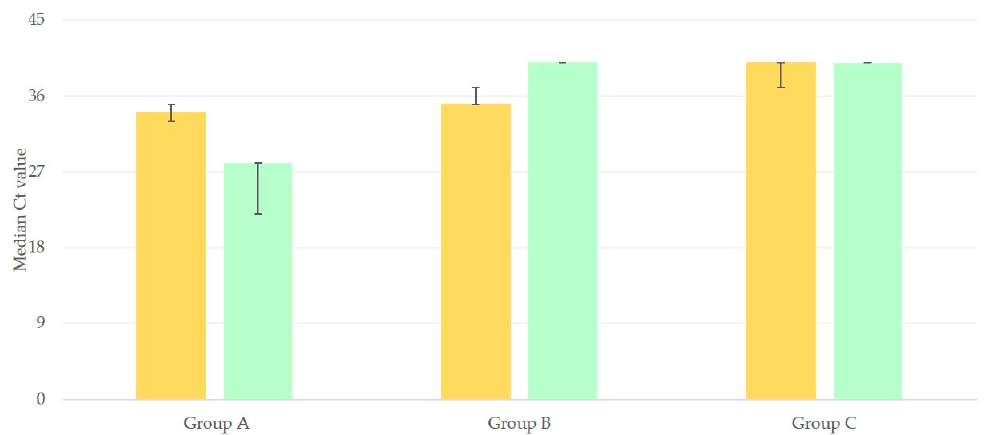
Figure 1. Median Ct values of rRT-PCR for the N gene, for nasopharyngeal samples obtained 3 days apart (initial sample: light ochre, second samples: light green) and processed under the same conditions (bars indicate min.–max. values).